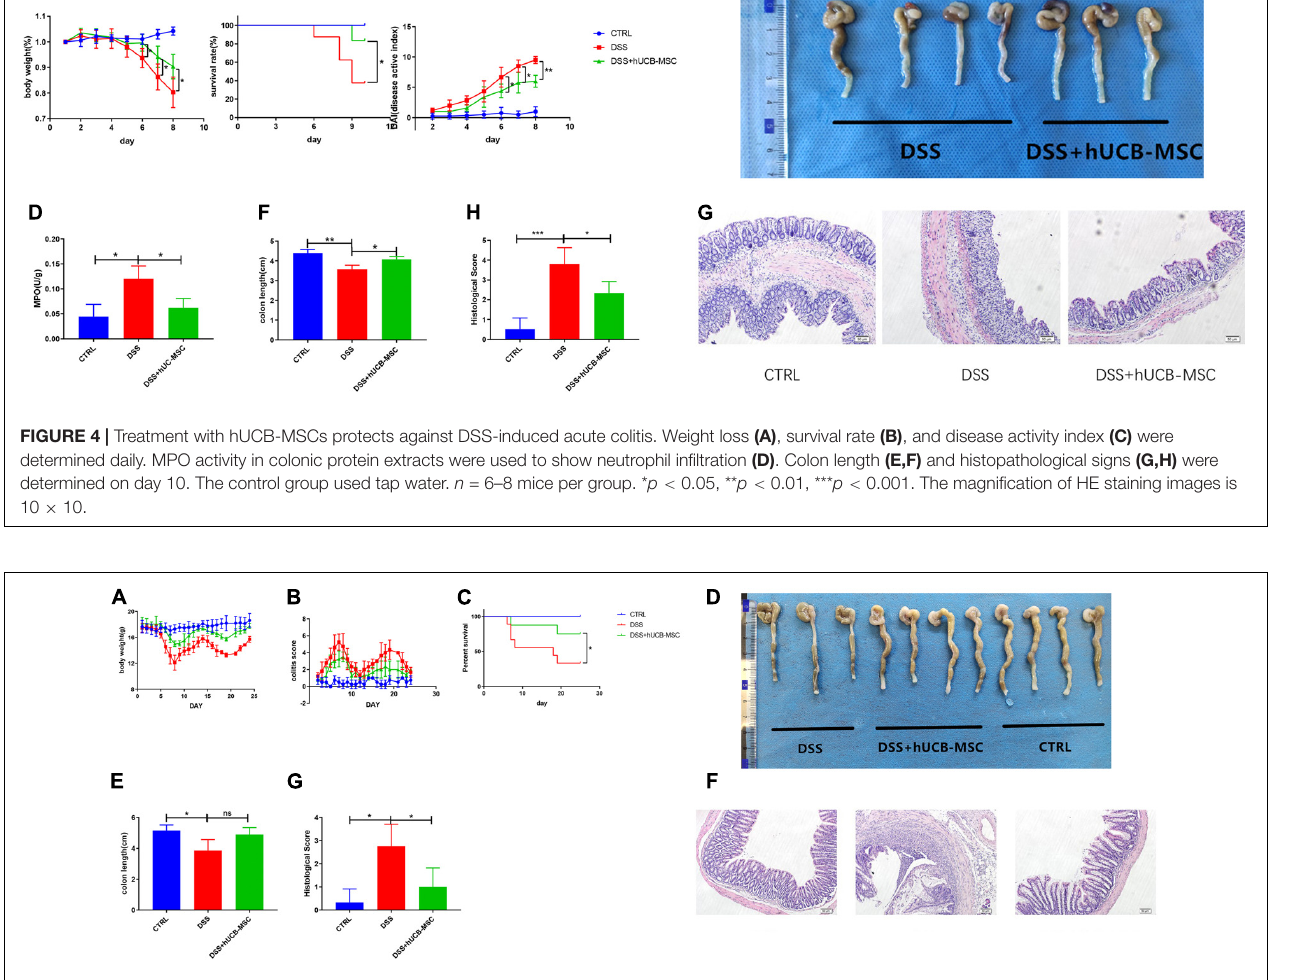
FIGURE 5 | hUCB-MSC ameliorated DSS-induced chronic colitis. Body weight (A) , colitis score (B) , and survival rate (C) were determined daily. Colon length (D,E) and histopathological signs (F,G) were determined on day 25. n = 5–6 mice per group. * p < 0.05 and ns, no significant difference. The magnification of HE staining images is 10 ×